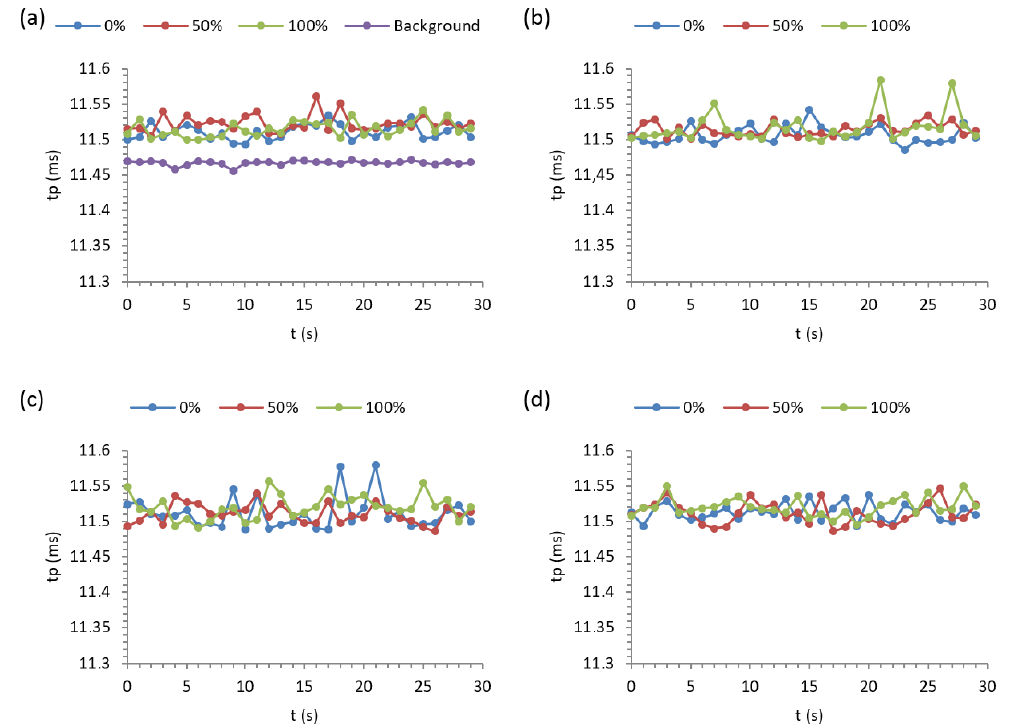
Figure 7. Graphs of the ultrasonic wave propagation time (AR41), with the direction of propagation opposite to the direction of airflow: ( a ) coal dust, ( b ) stone dust, ( c ) coal-stone dust, ( d ) limestone dust.